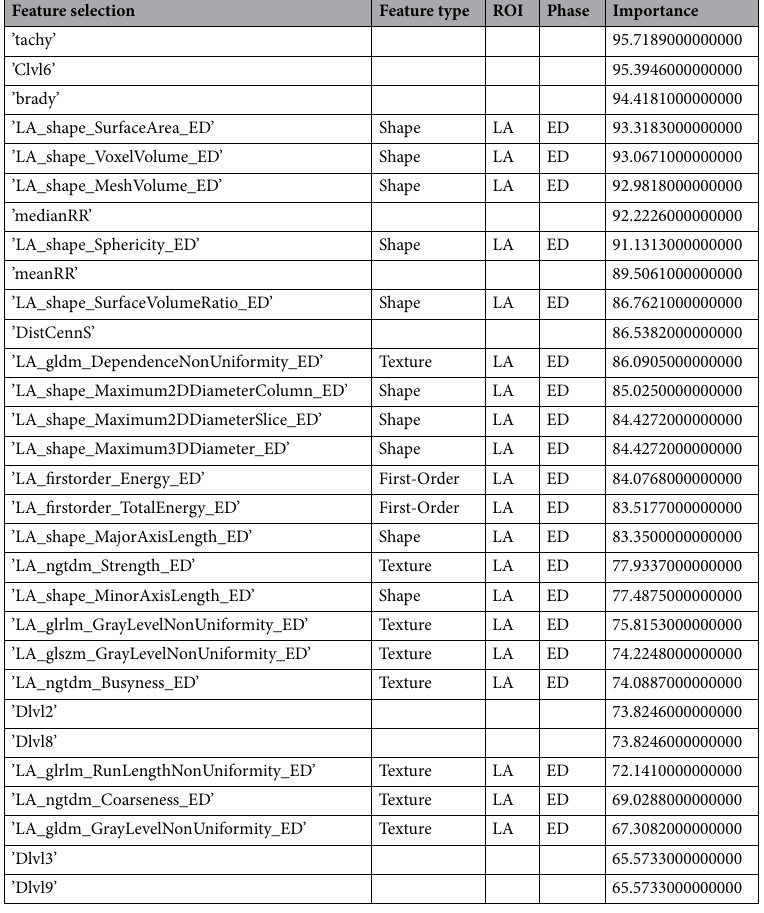
Table 2. Feature selection for AF for all participants for the electro-radiomics